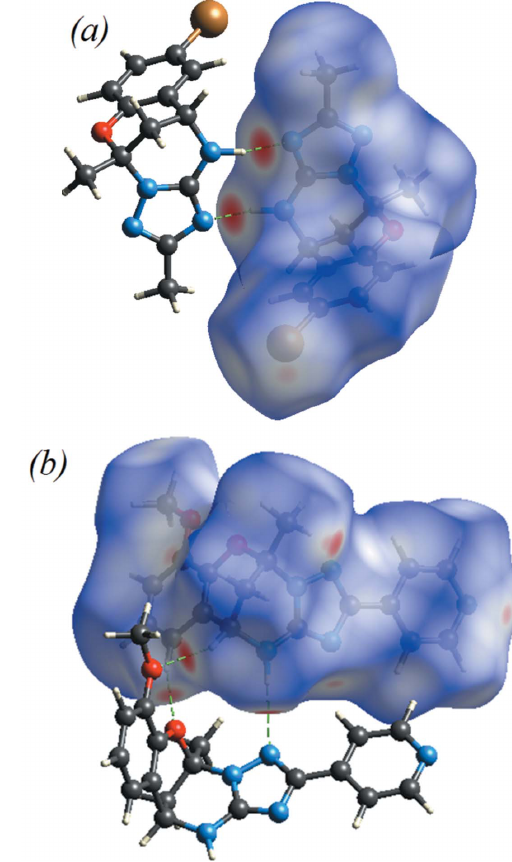
Figure 5 A view along the a axis of the crystal packing of compound II . Dashed lines denote intermolecular hydrogen bonds (Table 2).